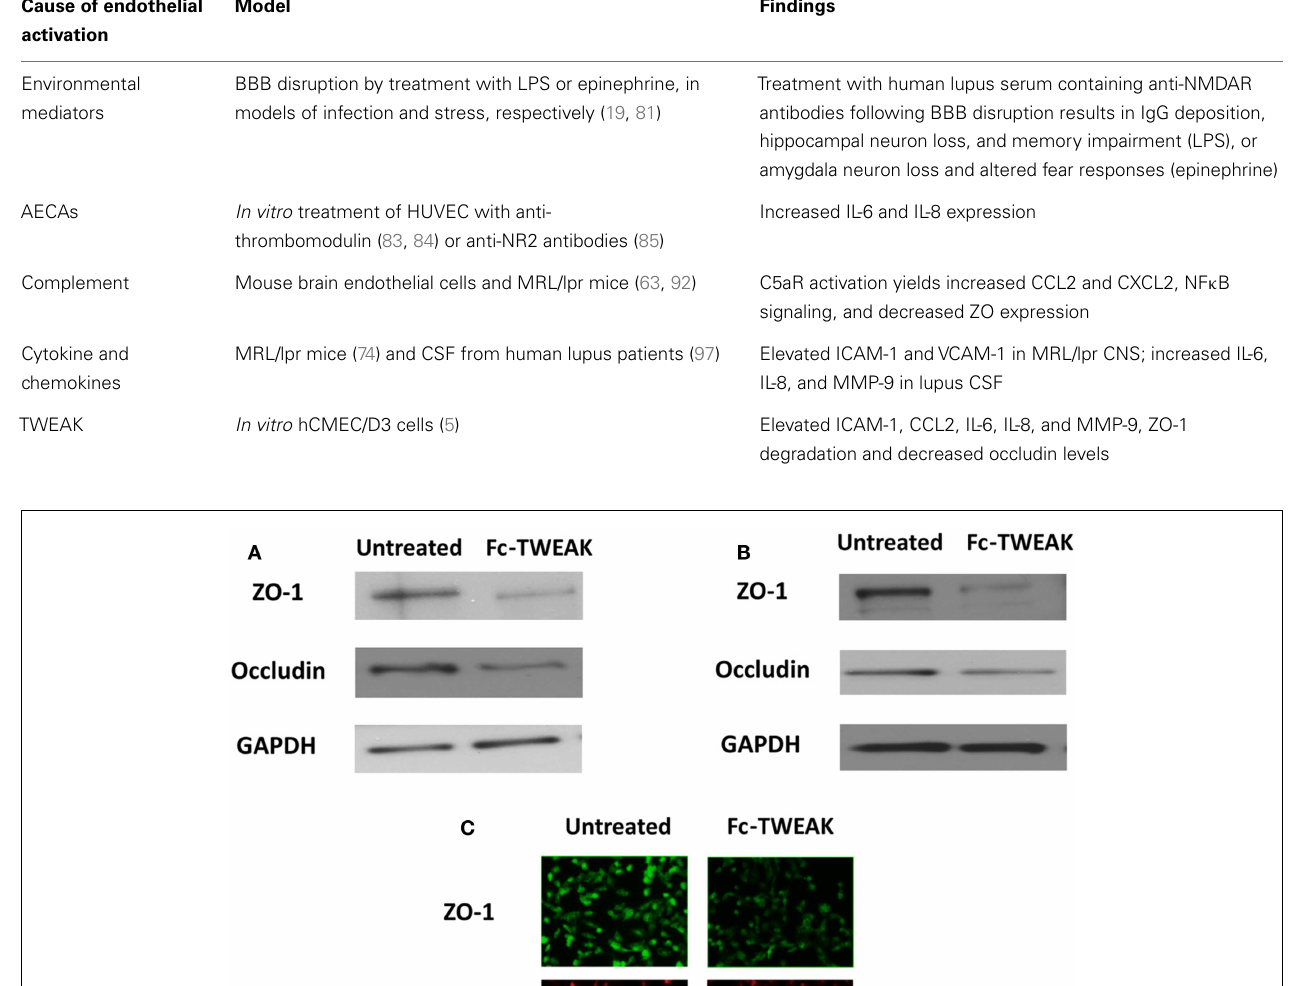
FIGURE 1 | ZO-1 and occludin expression after treatment with Fc-TWEAK . ZO-1 and occludin expression was measured by western blot. Treatment with Fc-TWEAK (100ng/mL, 48h) decreased ZO-1 and occludin expression in hCMEC/D3 cells (A) . ZO-1 and occludin expression was